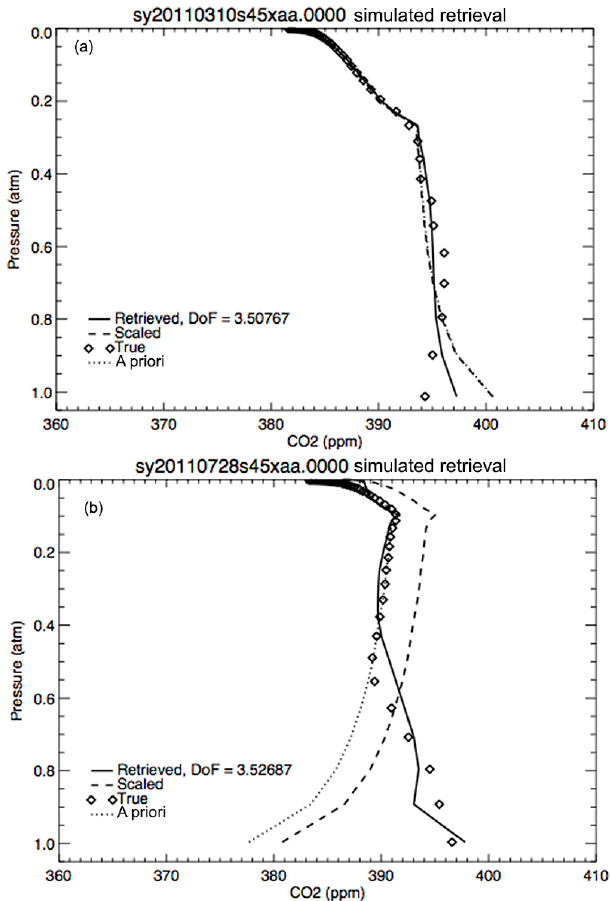
Figure 4. (a) Retrievals from a synthetic spectrum with no forward- model error. (b) As in (a) but assuming different true and a priori profiles.